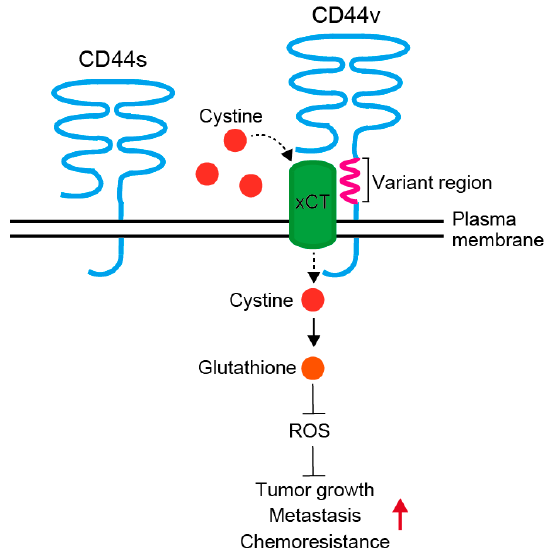
Figure 1. Regulation of oxidative stress by the CD44 variant isoform. Schematic illustration of